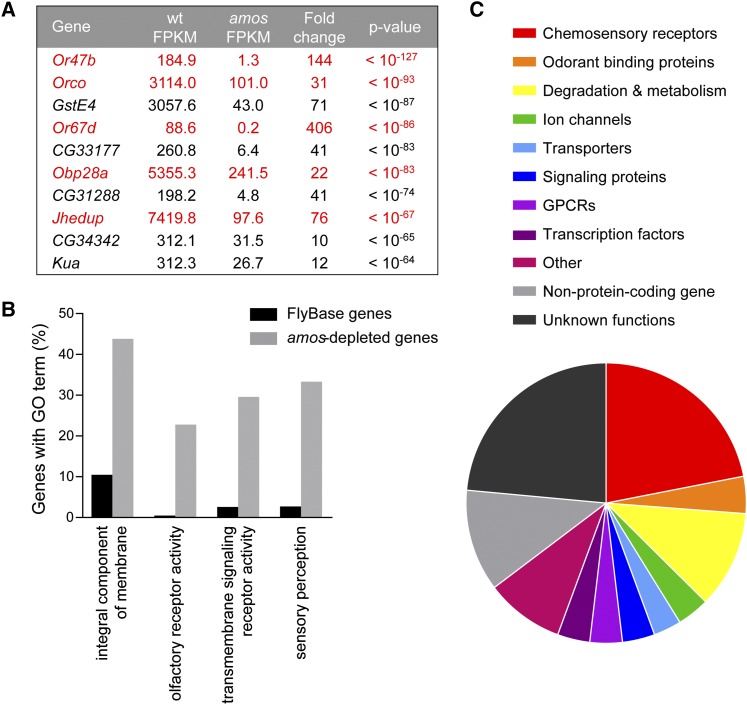
amos-depleted genes fulfill a variety of molecular functions. (A) The top ten differentially expressed genes based on p-value include five genes with known localization to single-walled sensilla (red). (B) GO term enrichment analysis of the 187 amos-depleted genes compared to all Drosophila genes listed in FlyBase reveals several enriched GO terms. (C) The chart depicts the frequency of amos-depleted genes falling into different functional categories.